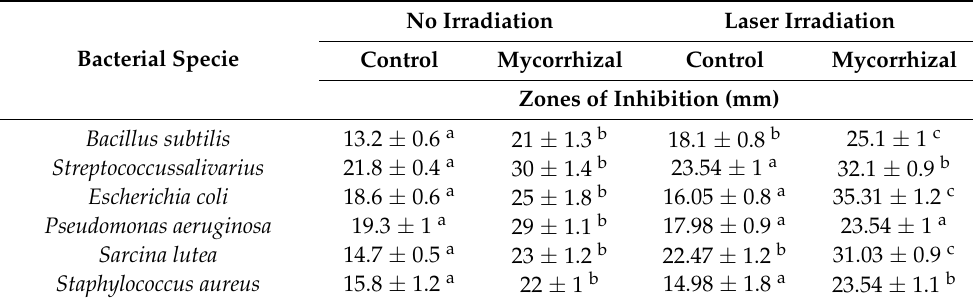
Table 5. Antibacterial activities of P. graveolens